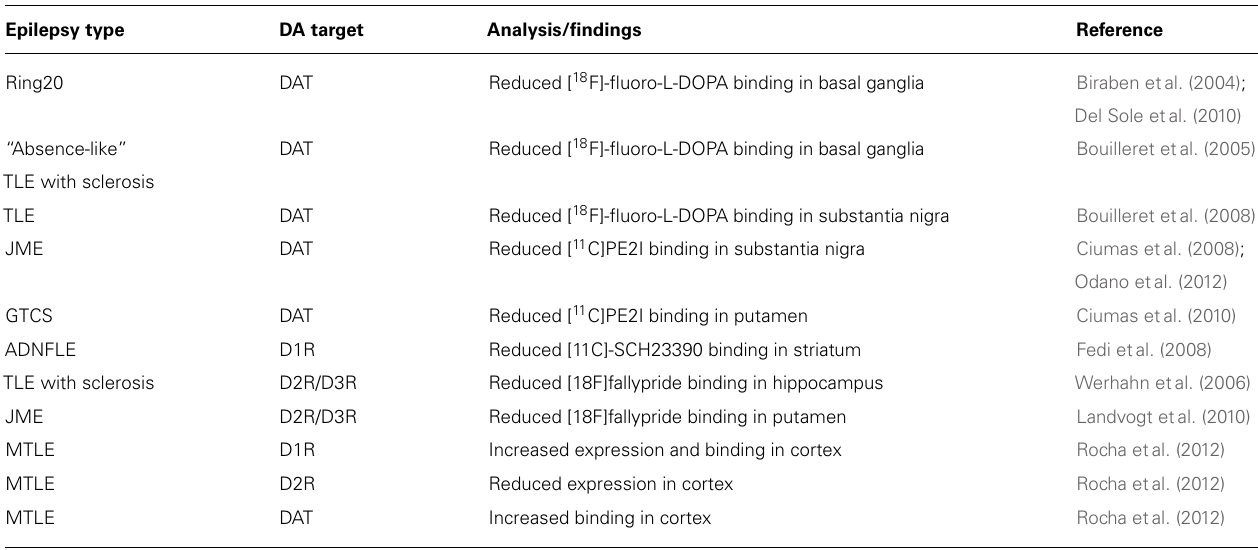
Table 1 | Dopamine signaling in epilepsy: human